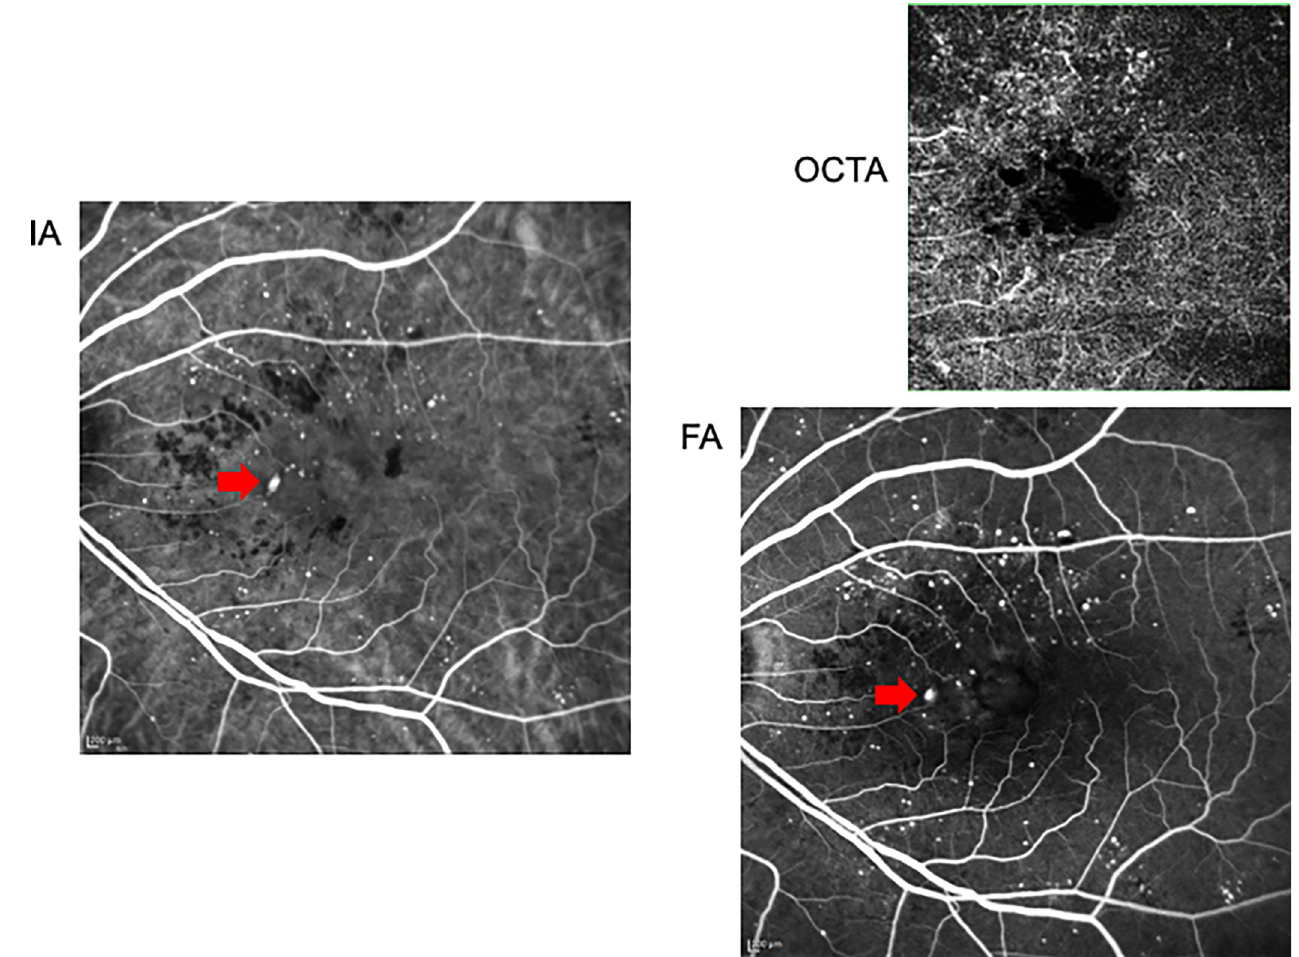
Fig 4. Detected MA of a non-responder case. 68-years-old male. There was a large MA (red allow) surrounded blockings by hard exudates in nasal macula area. IA and FA could detect the MA; OCTA could not